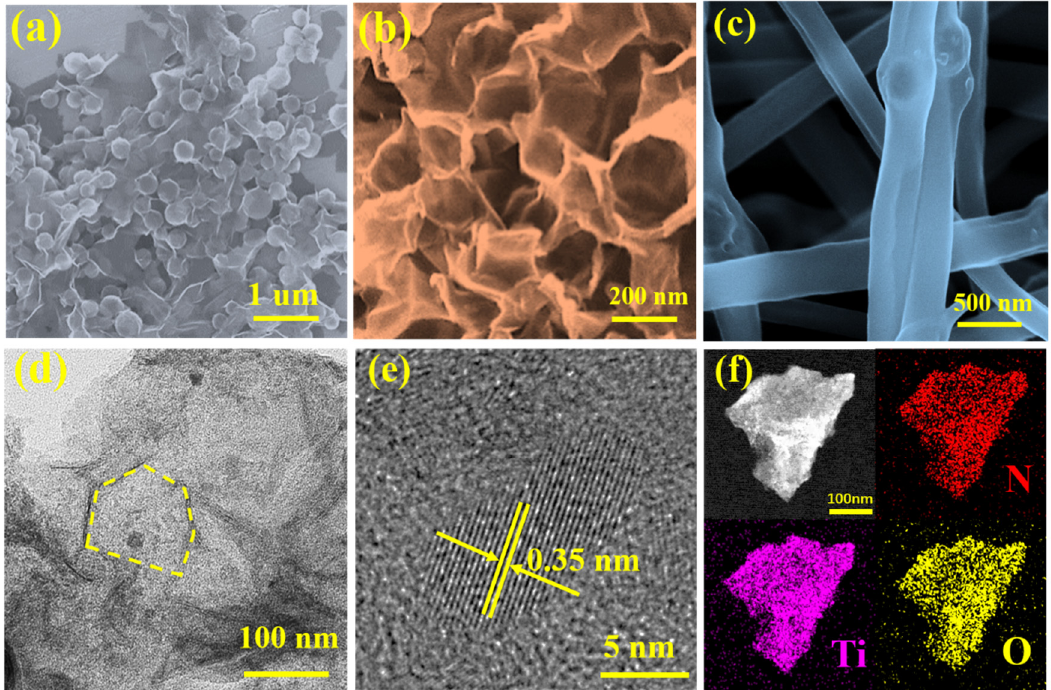
Figure 2. Morphology and structure characterizations of MXene@MF and N-MXene: SEM image of ( a ) MXene@MF; ( b ) N-MXene; ( c ) N-MXene-F; ( d ) TEM image of N-MXene; ( e ) HRTEM image of N-MXene; ( f ) STEM-EDX mapping of N-MXene.